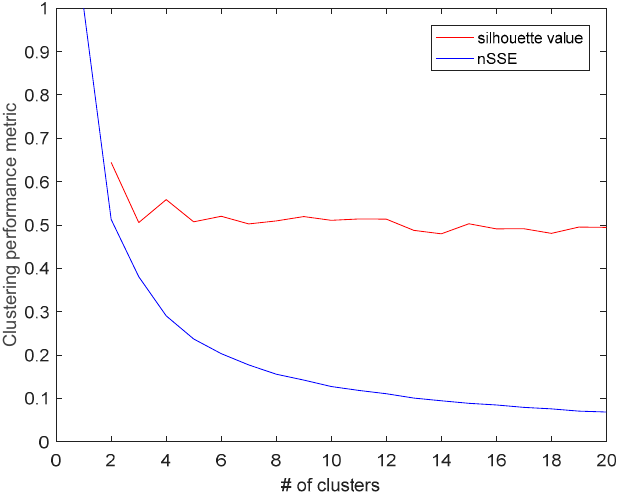
Figure 12. Impact of the number of clusters (between 1 and 20) on the used metrics (average silhouette value and normalized sum squared error).